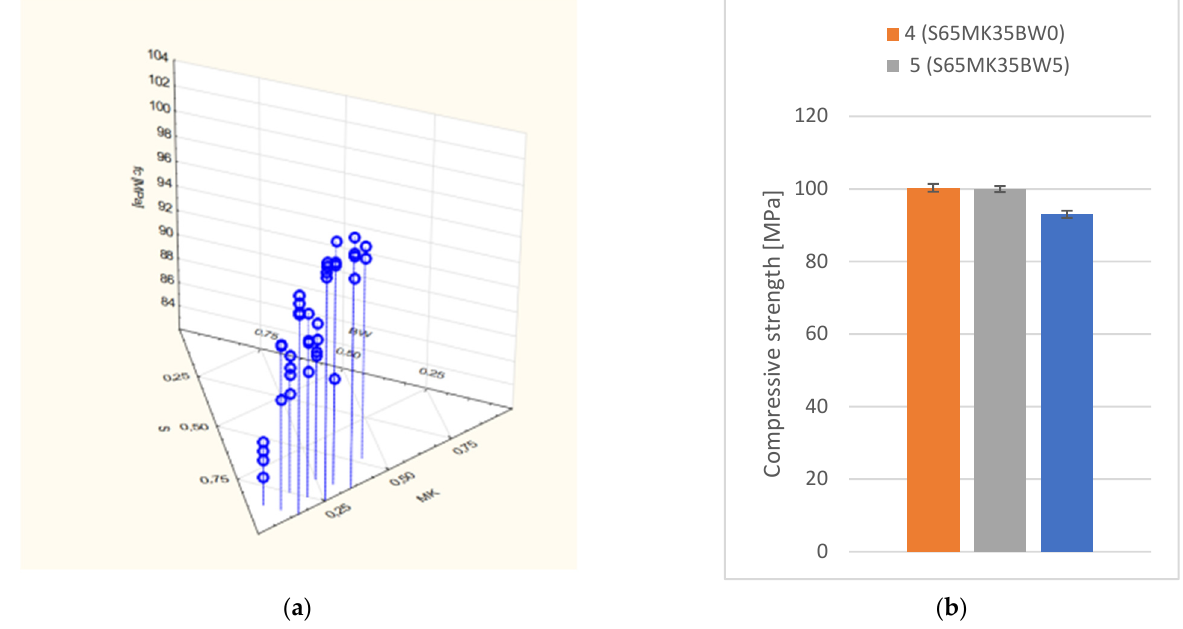
Figure 9. Compressive strength of the tested composites: ( a ) dependence in the experimental plan; ( b ) dependence on biochar content.